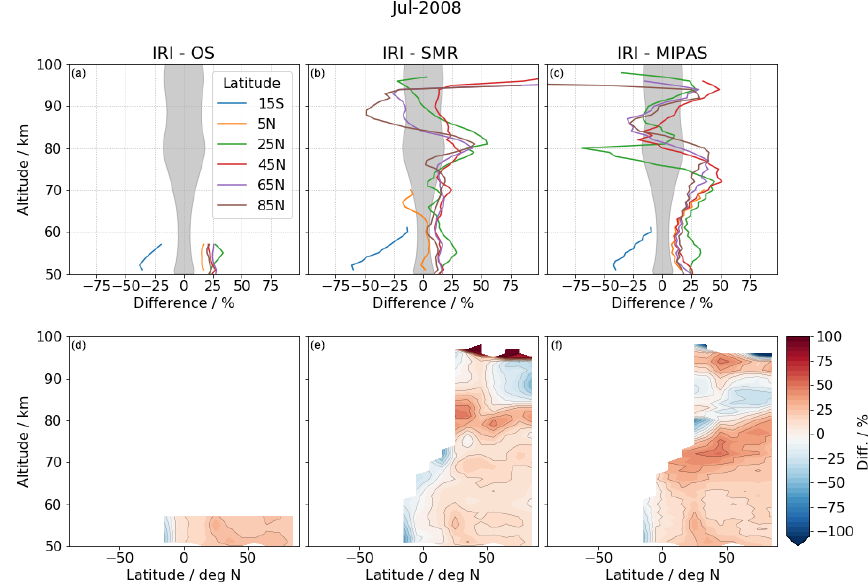
Figure 14. Relative difference of the zonally averaged ozone number density observed in July 2008, within 10 ◦ latitude bins. OS, SMR and MIPAS relative to IRI are presented in first, second and third column, respectively. The upper and lower row are 1D and 2D representations of this difference, respectively. The mean IRI ozone percentage error (precision) is also shown in grey in the upper